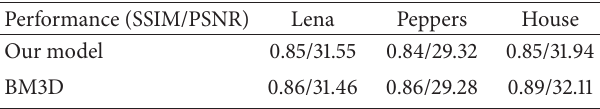
Table 6: PSNR and SSIM comparisons between our model and